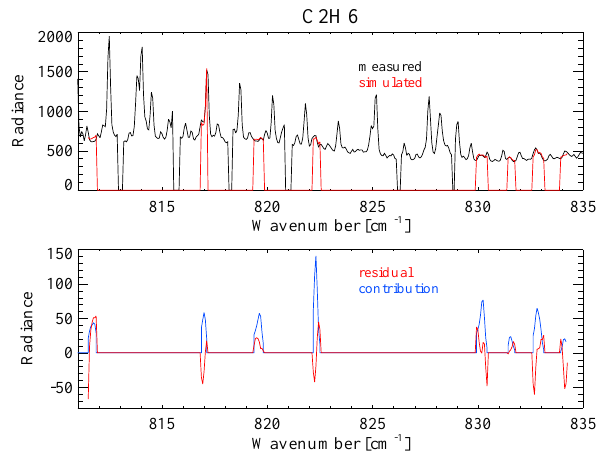
Fig. 2. Measured (black) and simulated (red) spectrum of a single C 2 H 6 measurement (upper panel) at 11.0km. The difference be- tween both is the residual (red) and is plotted in the lower panel. The spectral contribution of C 2 H 6 (blue) is calculated as difference between a forward simulation of the atmosphere taking into account all contributing gases and the corresponding forward simulation ex- cluding C 2 H 6 . Radiances are given in nW/(cm 2 srcm − 1 ). Zero ra- diances in calculated spectra and residual spectra reflect data points excluded from the analysis. The root mean squares (RMS) differ- ence for the shown set of microwindows is 29.5nW/(cm 2 srcm − 1